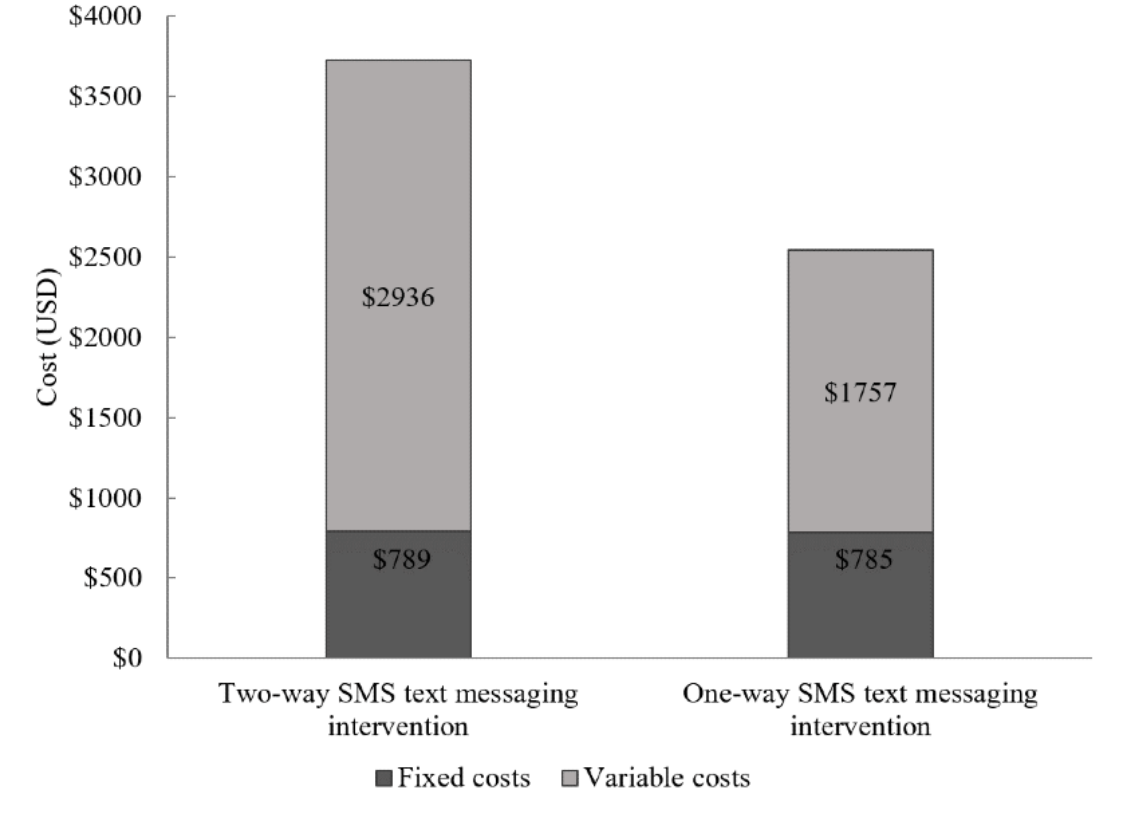
Figure 2. Cost per beneficiary by fixed and variable